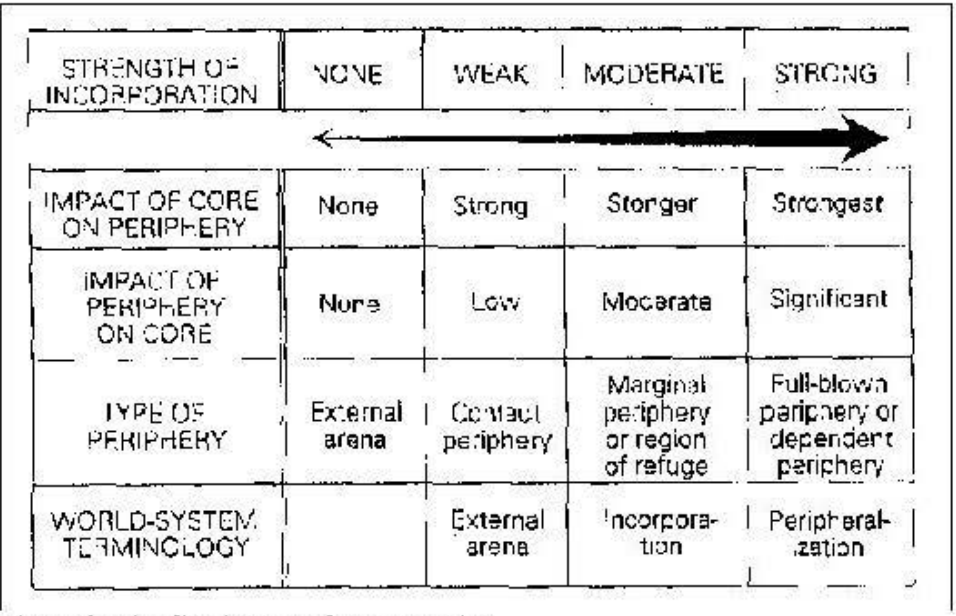
figure 1. The Conti1mum